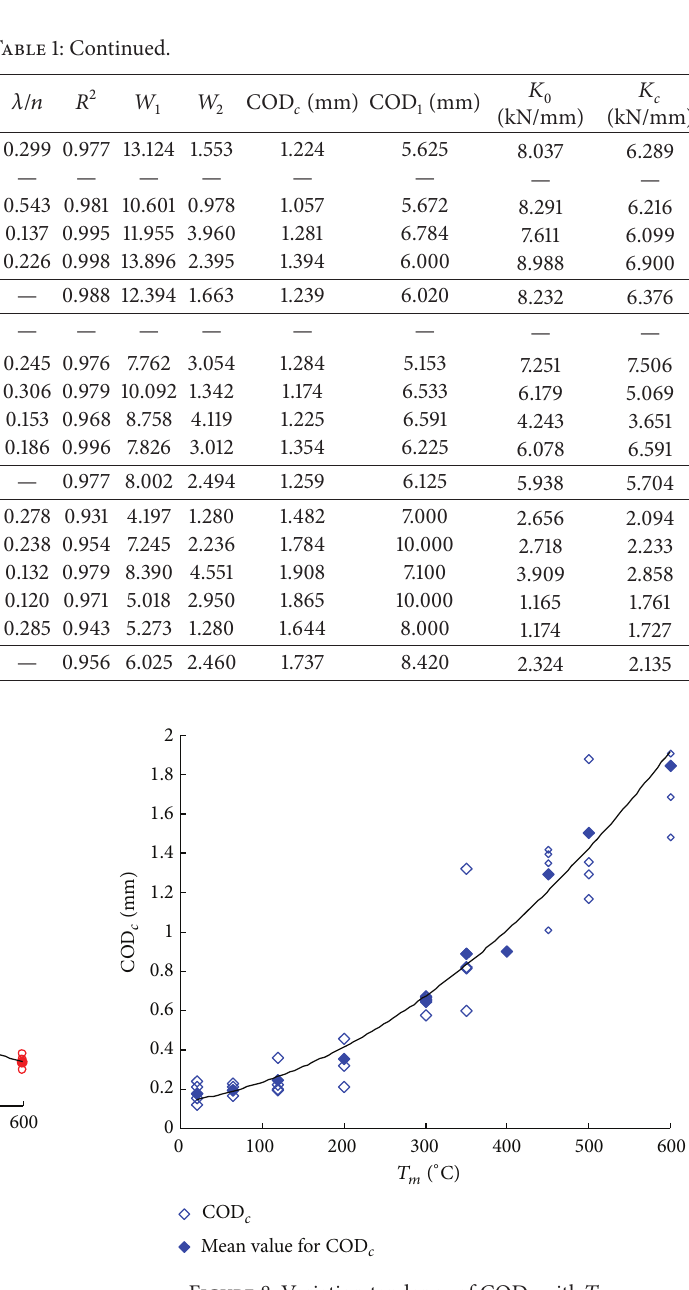
Figure 8: Variation tendency of COD 𝑐 with 𝑇 𝑚